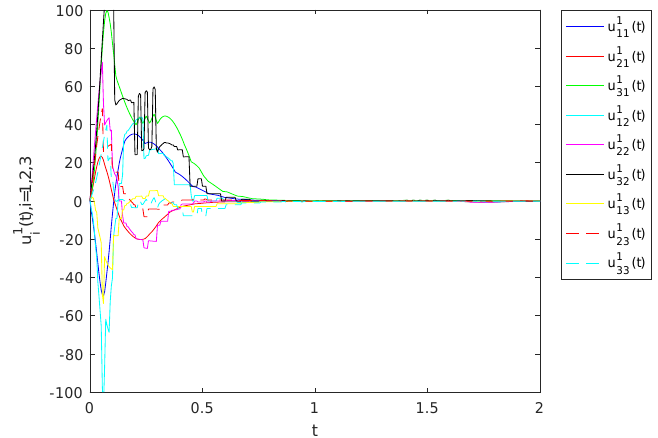
( 1 ) ( t ) in the first layer. ı